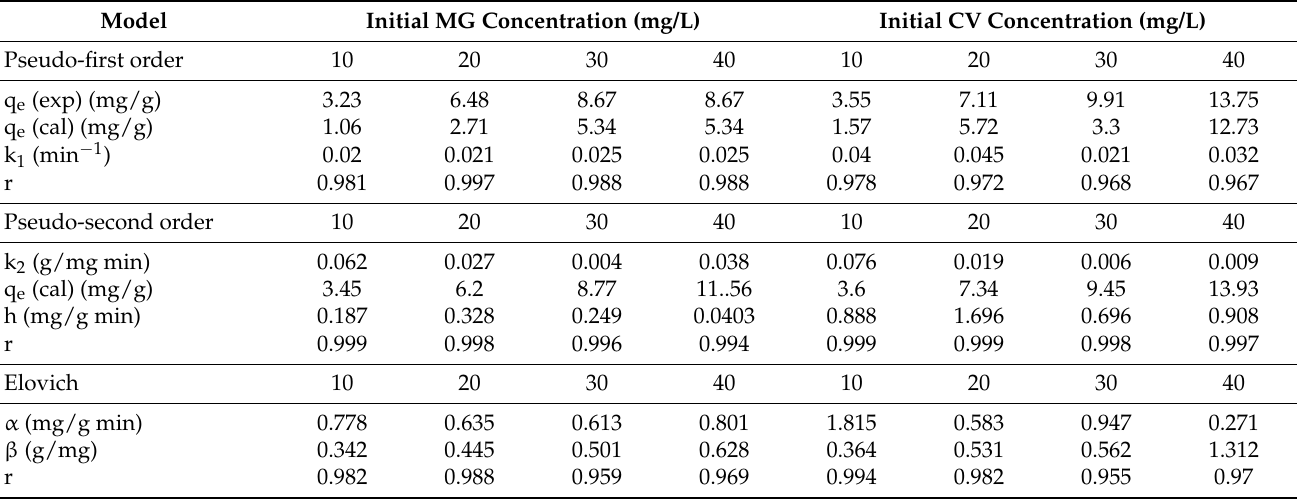
Table 5. Parameters of the kinetic models for the biosorption of MG and CV on ALP for different concentrations at 298